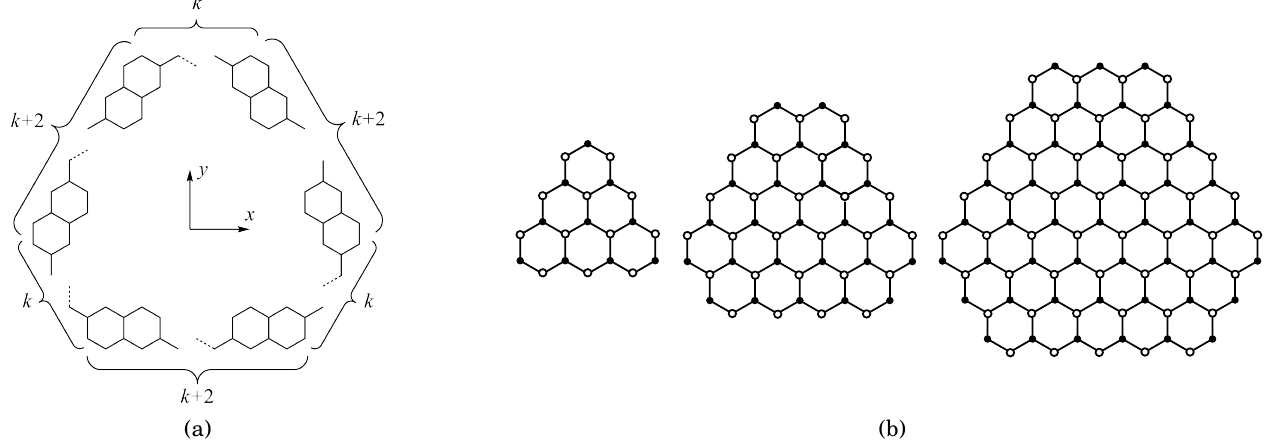
Figure 2: A family of convex benzenoids. (a) Schematic construction of the benzenoid H ( k + 2 , k, k, k ) . (b) The three , and H (5 , 3 , 3 , 3) . Coordinates ( x, y ) are defined relative smallest members of the family: H (3 , 1 , 1 , 1) ∼ = T 3 (3) , H (4 , 2 , 2 , 2)